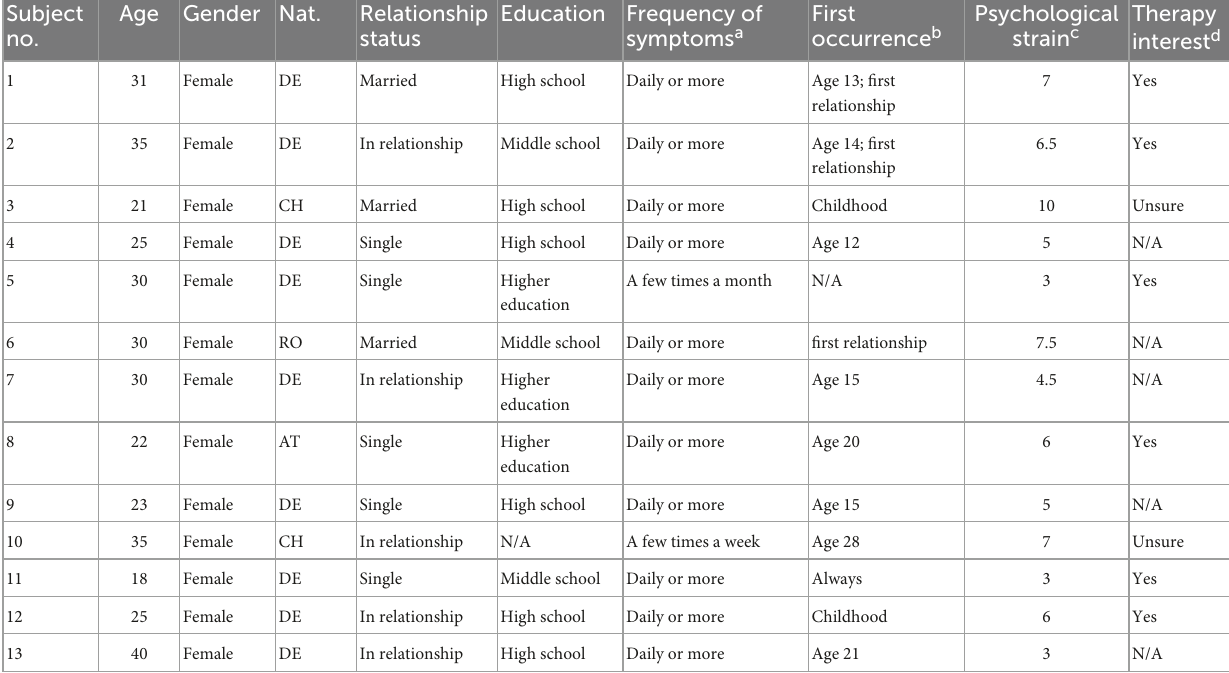
a Frequencyofsymptoms:howoftendoyouexperienceanysymptomsrelatedtoalexinomia? b Firstoccurrence:whendidyounoticeanydifficultyrelatedtosayingnamesforthefirsttime? c Psychologicalstrain:subjectivedegreeofpsychologicalstrainrelatedtoalexinomiaonascalefrom0to10. d Therapyinterest :